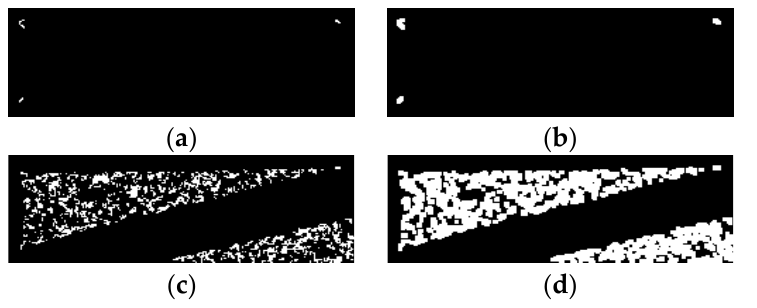
Figure 10. Results of corner detection before and after dilation and erosion. ( a ) corner detection before dilation and erosion, no noise. ( b ) corner detection after dilation and erosion, no noise. ( c ) corner detection before dilation and erosion, σ = 0.05. ( d ) corner detection after dilation and erosion, σ = 0.05.